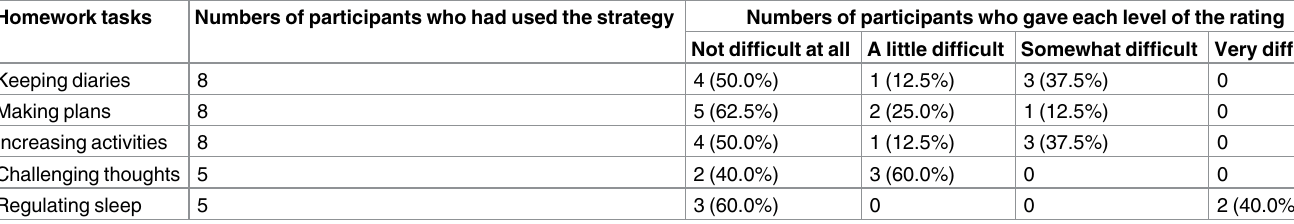
Table 4. Participant ratings of the difficulty in completing homework tasks (n =